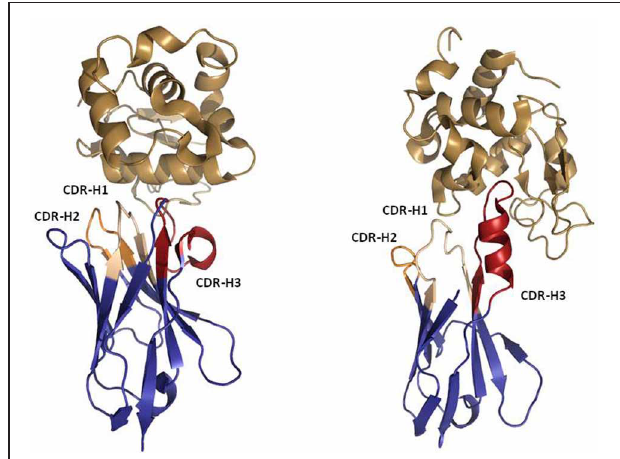
FIGURE 6 | Ribbon representation of Llama VHH (left) and Shark IgNAR (right) in complex with Hen Egg White Lysozyme (HEL). PDBID 1OP6 was used to represent the VHH:HEL complex. PDBID 2I26 was used to represent the IgNAR:HEL complex. Note the protruding IgNAR CDR-H3 blocking the active site of HEL, which contrasts with the bended VHH CDR-H3 that recognizes a flat epitope. The Figure was generated using